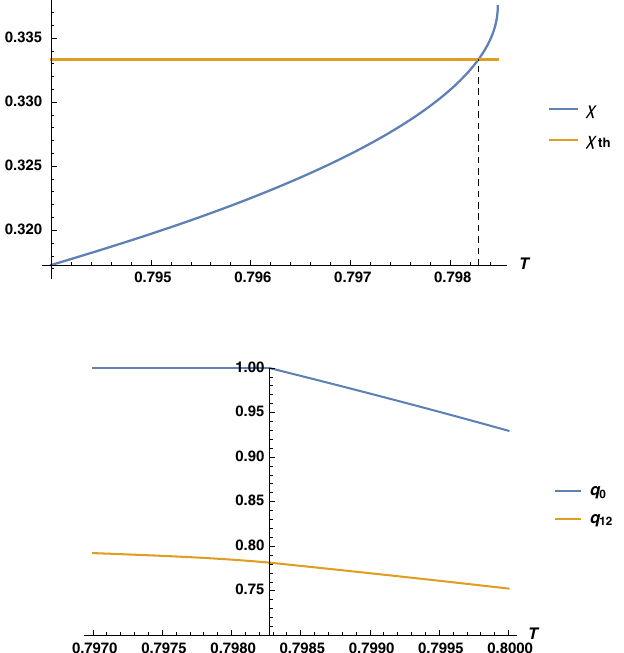
FIG. 11. Upper panel: Susceptibility χ in the RS state following 0 . 7982756 the solution for the ( 3 þ 4 )-spin model. Here, T SF ¼ is defined by the condition χ ¼ χ , marked by a vertical dashed mg line. Lower panel: Since the vertical axis is located exactly at T ¼ T , values for q 0 and q 12 on the right are from the RSB SF aging solution, while those on the left are from the RS state- following